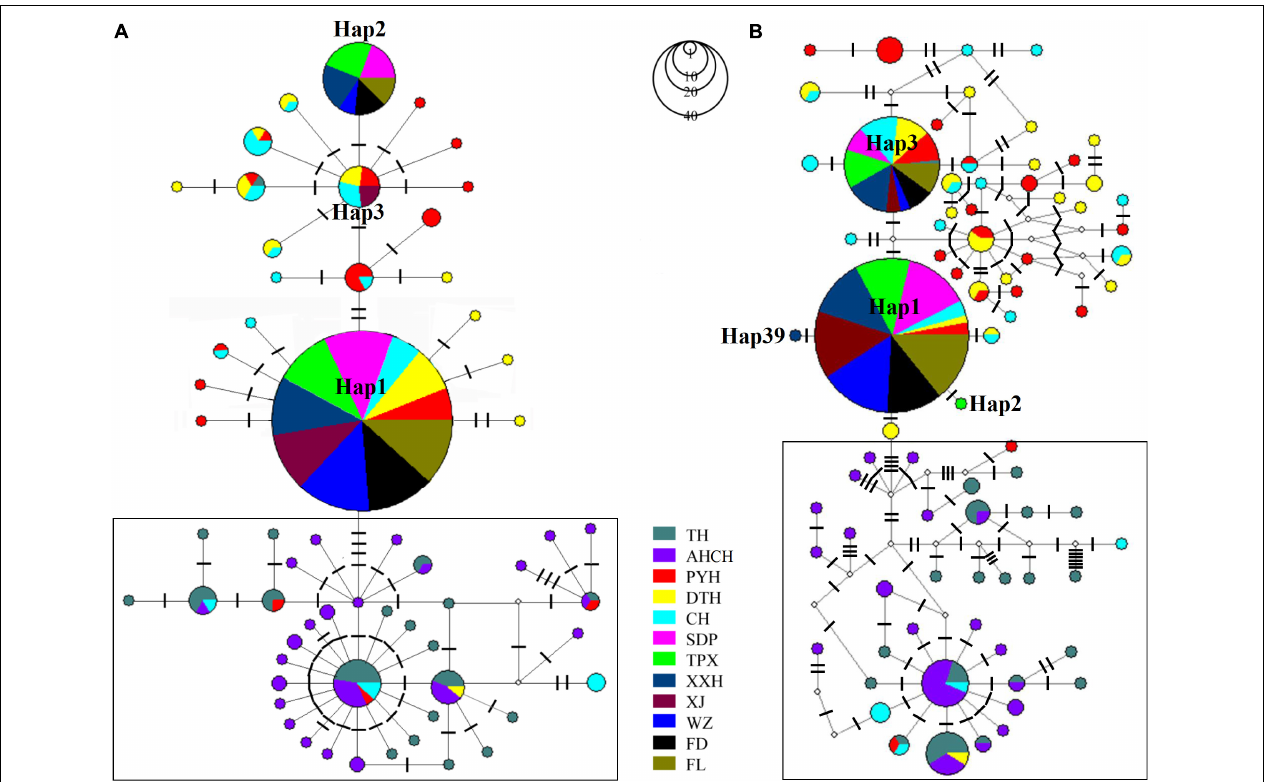
FIGURE 3 | Median-joining network of haplotypes of C. brachygnathus from 12 sites in the Yangtze River basin, China, inferred from Cyt b (A) and D-Loop (B) gene sequences. Each circle represents a haplotype, and its size is proportional to its frequency.